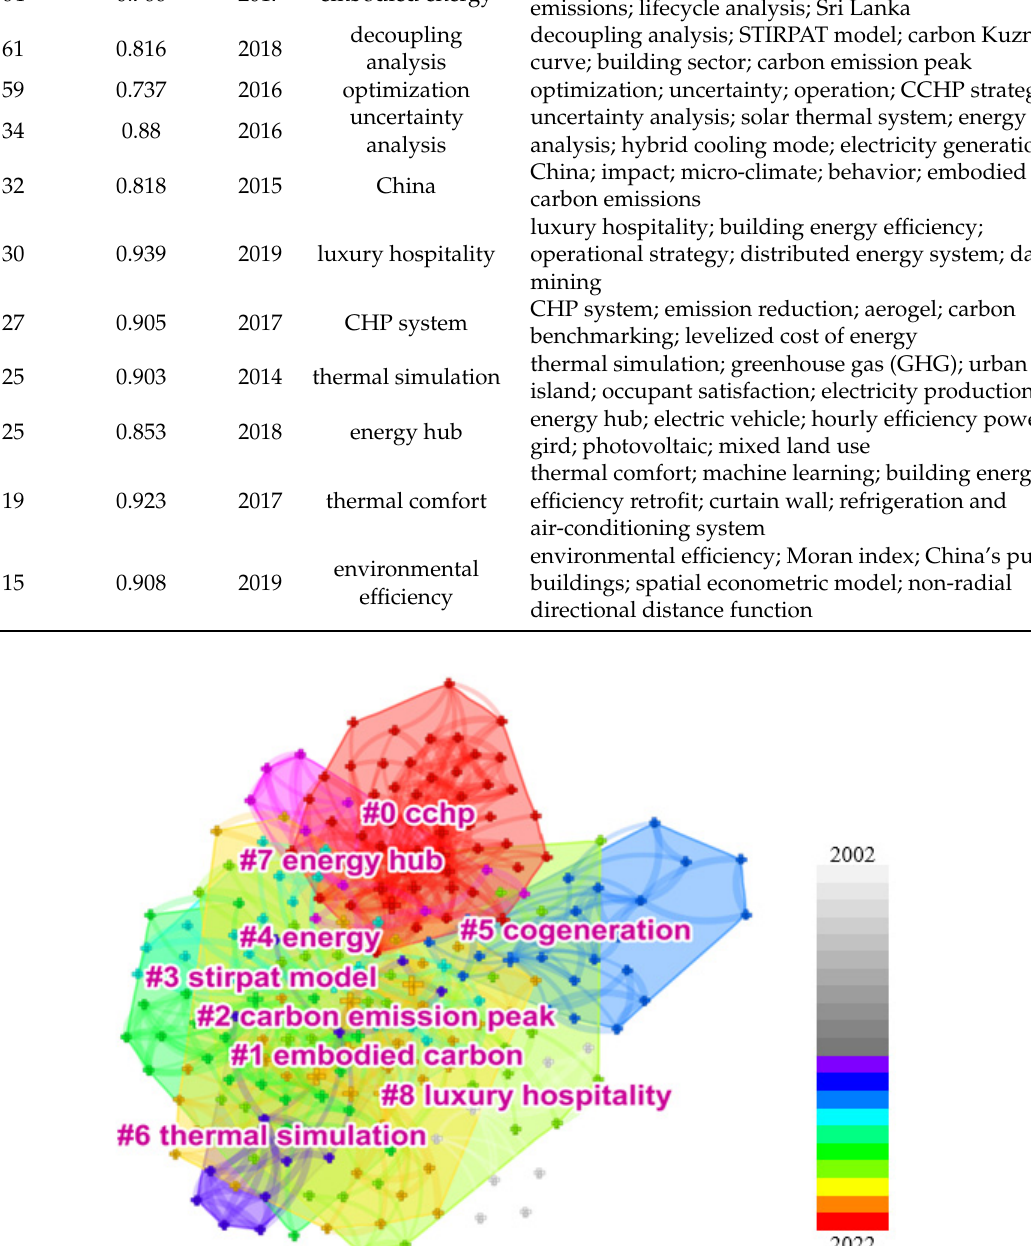
Table 4. Cluster by keywords in the study of carbon emissions of public buildings.